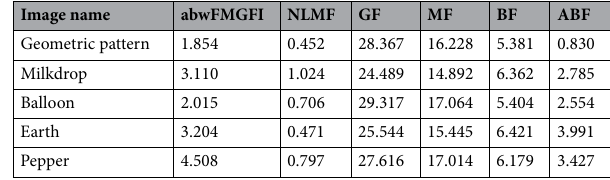
Table 11. Comparison of the RMSE values of each sample image filtered using each filter (regarding edge preservation performance).